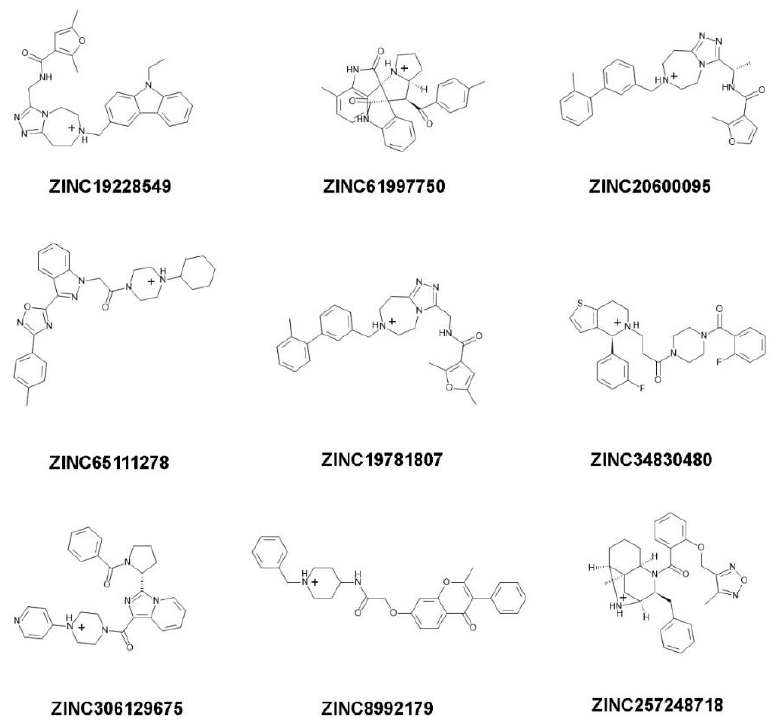
Figure 8. Structure, protonation, and charge at pH 7.4 of candidate ligands that do not interact with the C-terminus of NMT1. These ligands do not engage the C-terminus of NMT in a salt bridge or in a hydrogen bond.